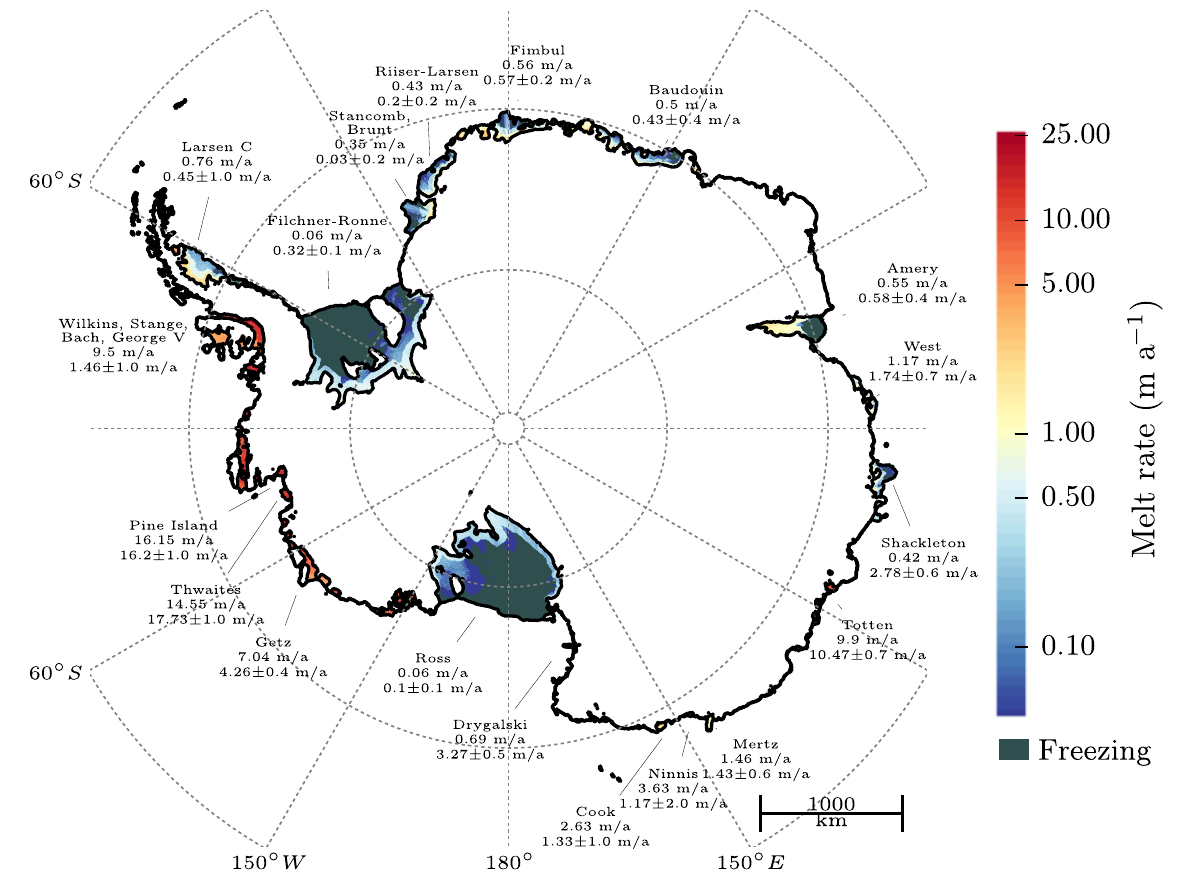
Figure 5. Sub-shelf melt rates for present-day Antarctica computed with PISM+PICO. The mean melt rate per ice shelf (upper numbers) is compared to the observed melt rates (lower numbers with uncertainty ranges) from Rignot et al. (2013). In the model, the same parameters = 2 × 10 − 5 ms − 1 and C = 1Svm 3 kg − 1 are applied to all ice shelves around Antarctica. The respective oceanic boundary condition are γ ∗ T shown in Fig. 2. Ice geometry and bedrock topography are from the BEDMAP2 data set on 5km resolution (Fretwell et al., 2013). Refreezing occurs in some parts of the larger shelves like Filchner-Ronne and